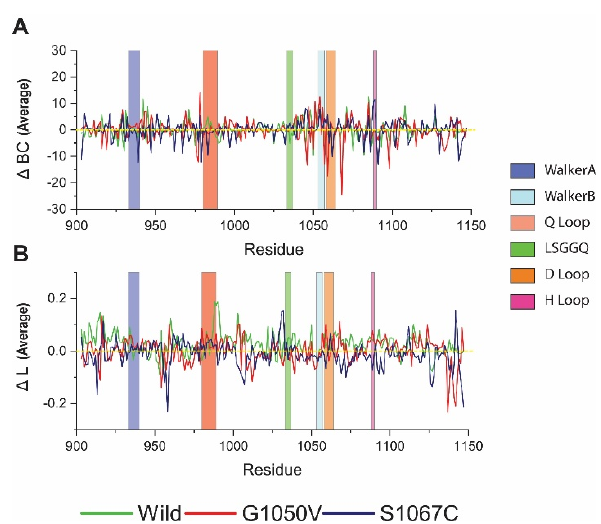
Figure 6. Analysis of the effect of variants in dynamic residue network. ( A ) Betweenness centrality (ΔBC); ( B ) average shortest path (ΔL). Here, green, red, and dark blue describe wild, G1050V, and S1067C, respectively.